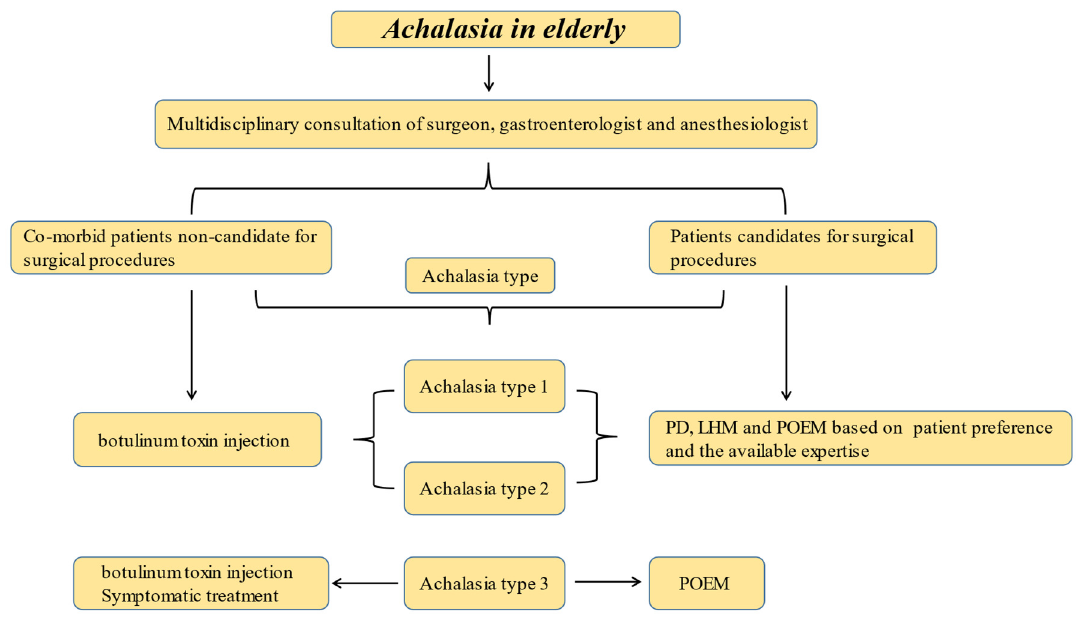
Figure 1. A proposed algorithm for the management of achalasia in the elderly.